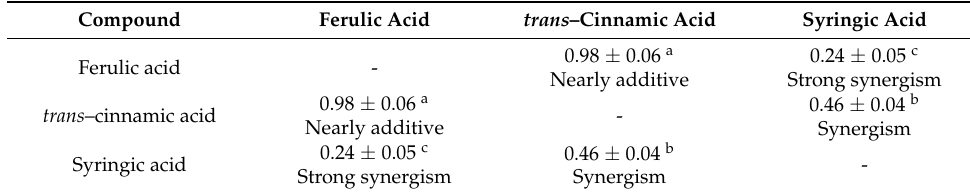
Figure 5. Dose-normalized isobolograms for chosen phenolic acids with thyroid peroxidase activation activity. ( A ) trans - cinnamic acid and ferulic acid, ( B ) syryngic acid and ferulic acid, ( C ) syringic acid and trans -cinnamic acid). Table 4. Combination index (CI) value between mixtures consisting of two polyphenols on thyroid peroxidase activity, n =